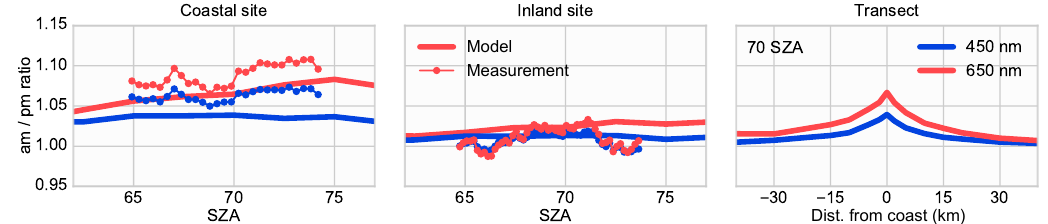
Figure 7. Measured and modelled am–pm ratios of the zenith radiance at the two locations over the day. Measured ratios are only available in the SZA range 65–75 ◦ because of clouds around noon. The am–pm ratios at the coast increase with SZA and wavelength with little variation 15km inland. Right panel: modelled ratios of zenith radiances at 70 ◦ SZA for 450 and 650nm, along the transect perpendicular to the coastline. The am–pm ratio reaches a maximum of about 1.07 directly at the coast and decreases below 1.01 further than 30km from the